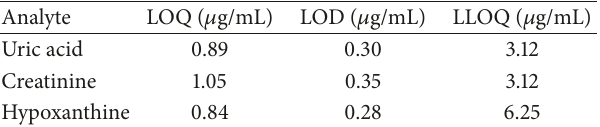
Table 3: Limit of quantification (LOQ), limit of detection (LOD), and lower limit of quantification (LLOQ) for uric acid, creatinine, and hypoxanthine.